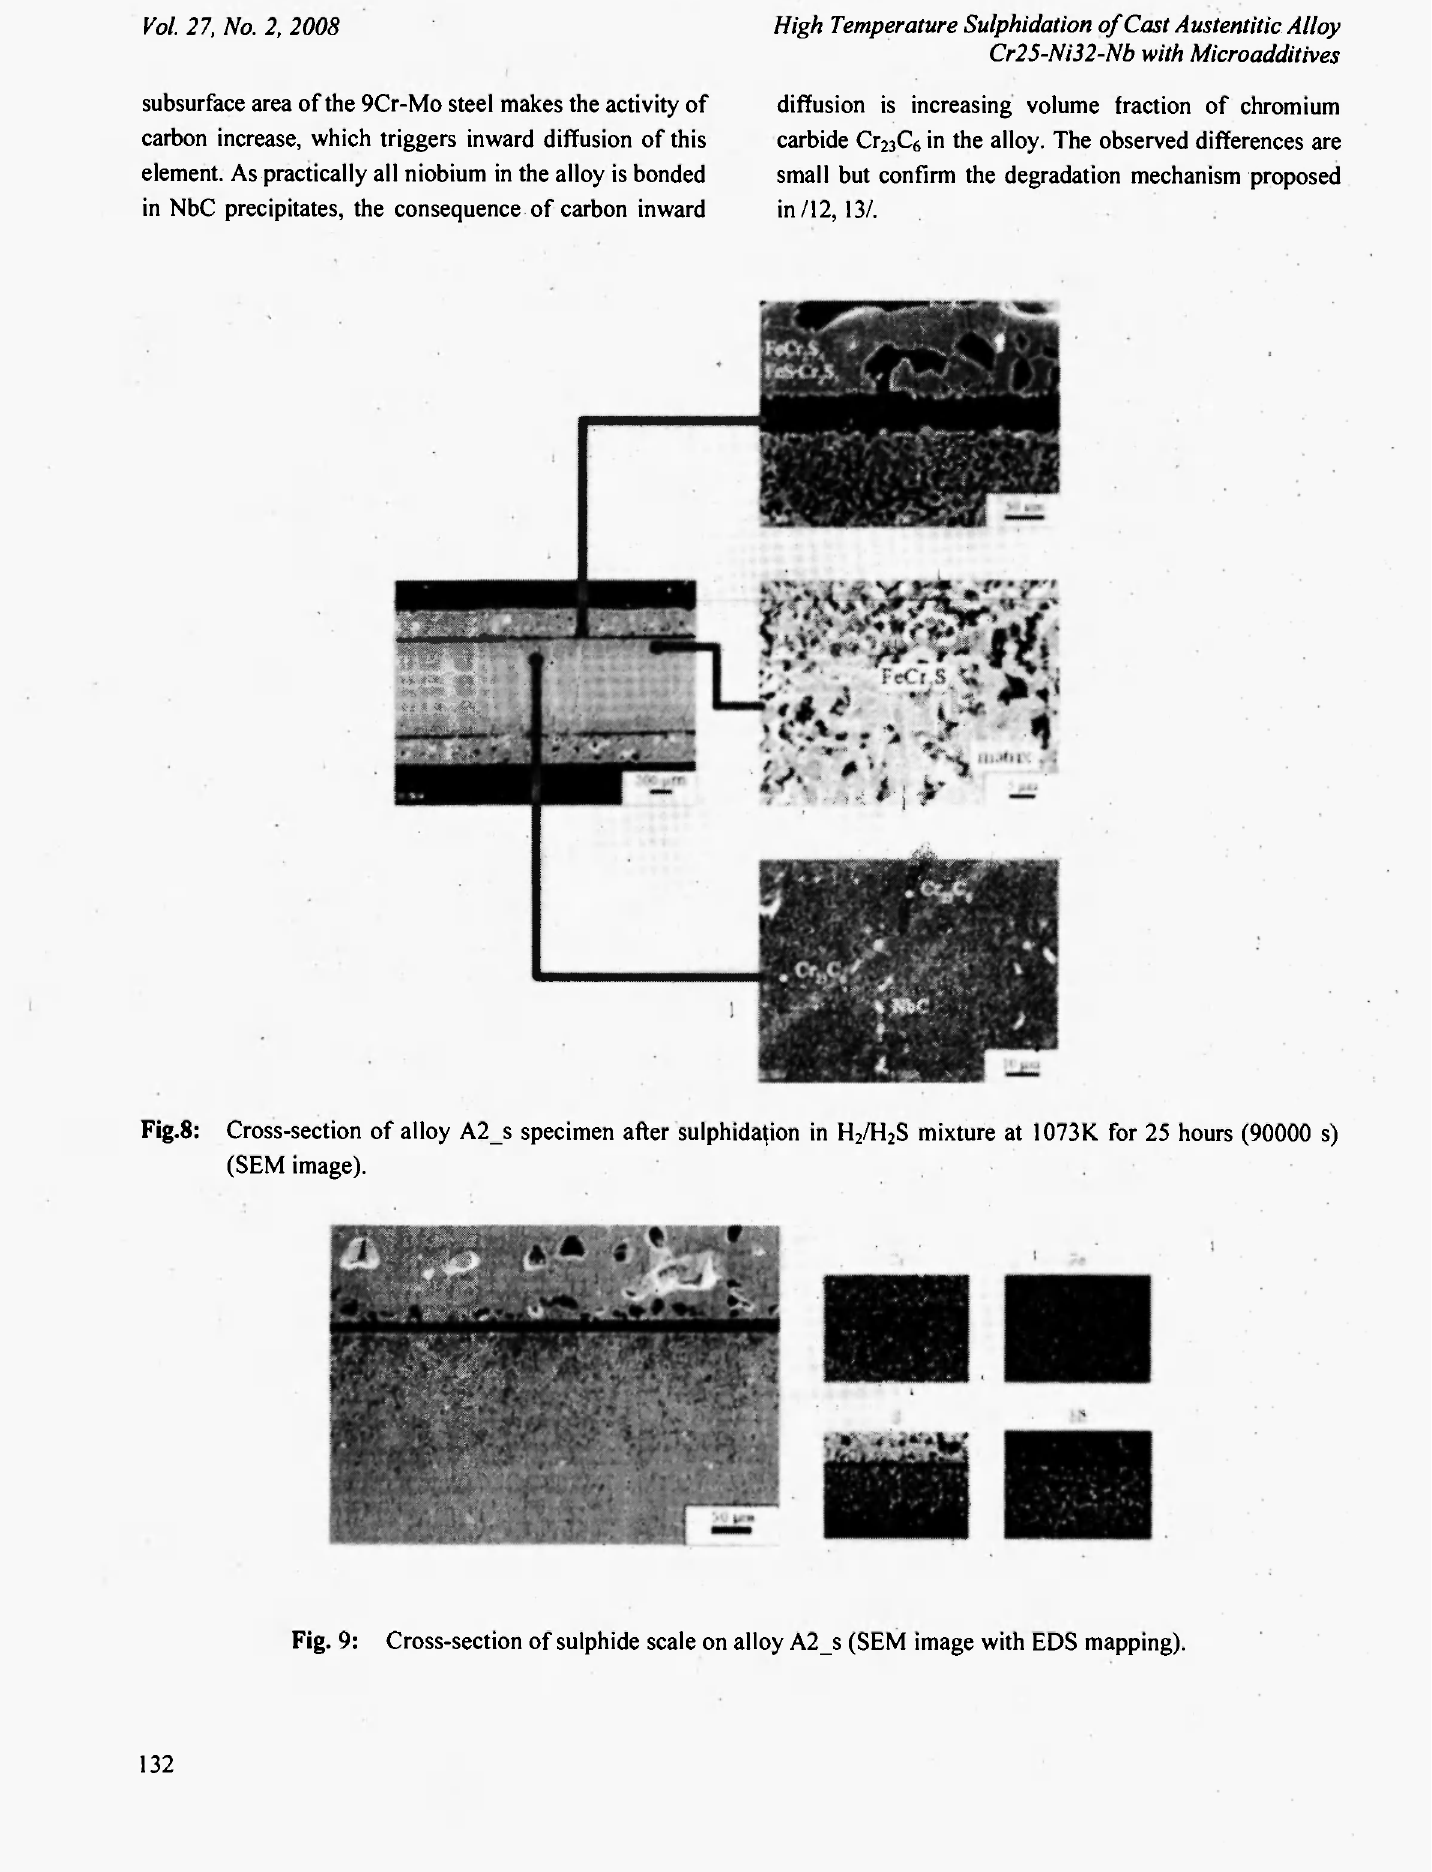
Fig. 9: Cross-section of sulphide scale on alloy A2_s (SEM image with EDS